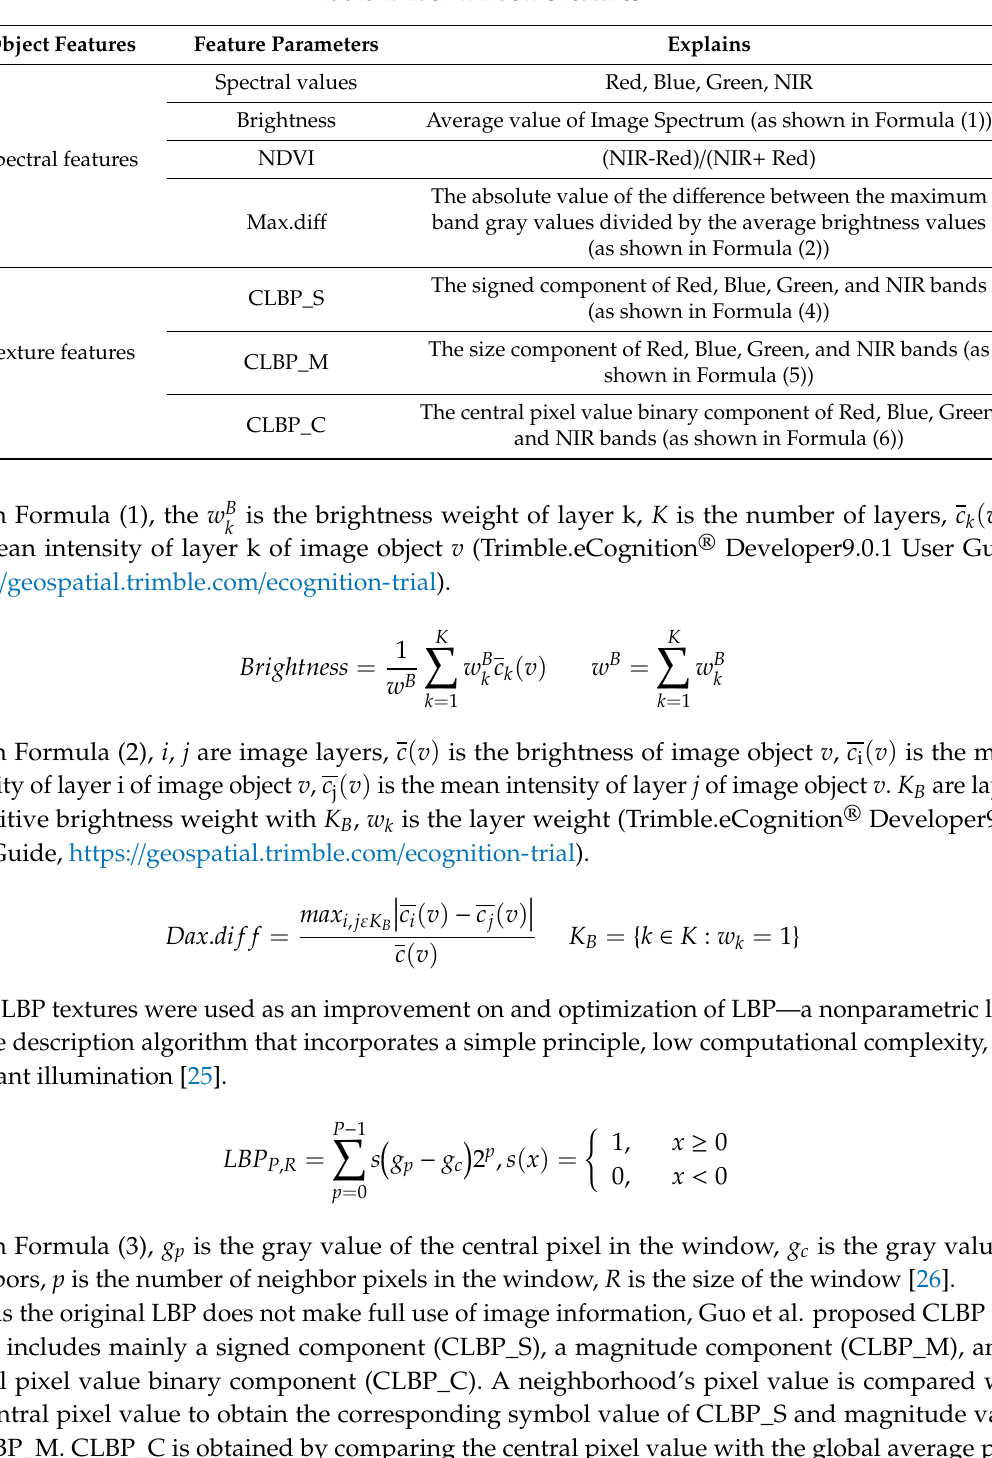
Table 4. Each window’s